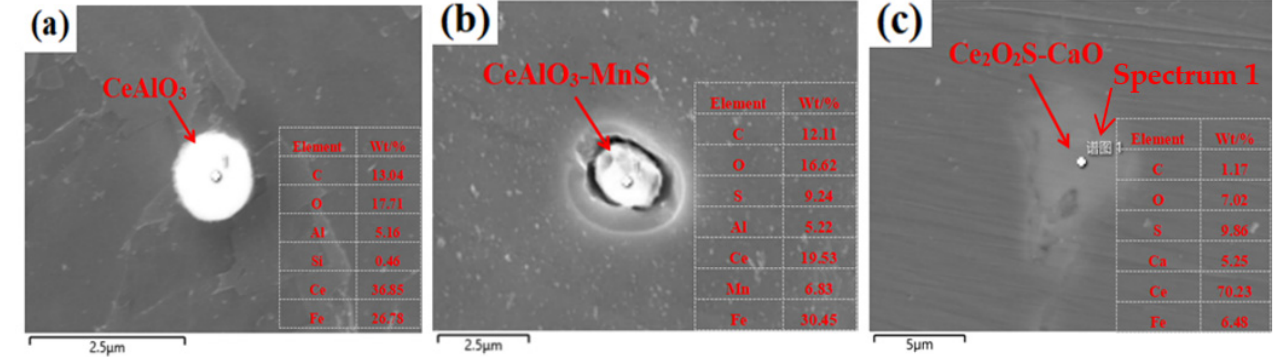
Figure 5. Morphology and compositions of inclusions in 2# as-cast tested steel. ( a ) CeAlO 3 ; ( b ) CeAlO 3 -MnS; ( c ) Ce 2 O 2 S-CaO.